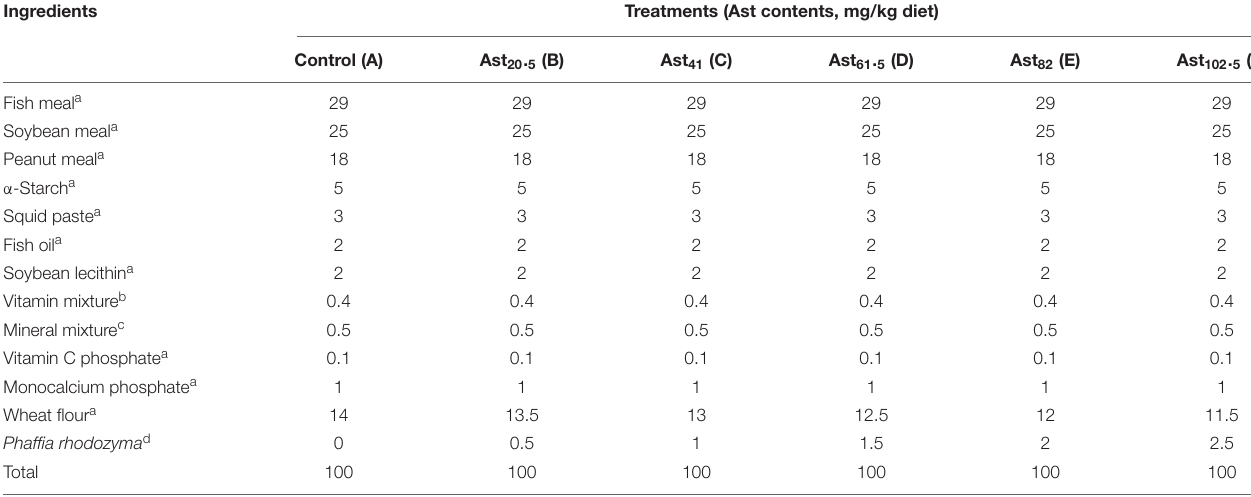
TABLE 1 | Formulation and composition of the experimental diets (%, dry matter basis).